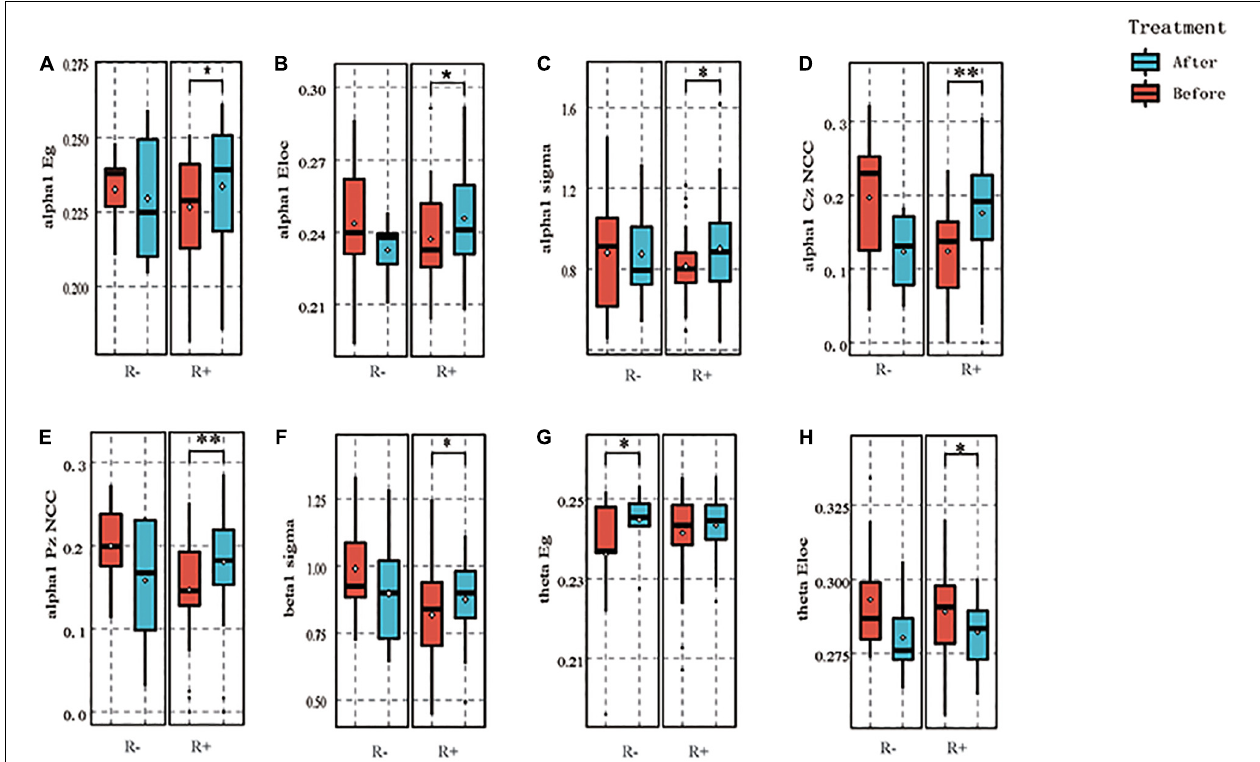
FIGURE 4 | The graph theory results for both groups. α 1 band: in the R + group, the area under the global efficiency curve increased after stimulation compared with before, p = 0.047 (A) , the area under the local efficiency curve increased compared with before, p = 0.033 (B) , and its small-world index sigma increased after stimulation, p = 0.026 (C) , whereas in the R- group, the above three indexes did not change significantly, p = 0.679, 0.640, and 0.924, respectively. The cluster coefficient of Cz nodes in the R + group increased compared with pre- stimulation, p = 0.003, while that of the R- group decreased after stimulation, p = 0.031 (D) , the cluster coefficient of Pz nodes in the R + group increased compared with that before stimulation, p = 0.003, while that of the R- group did not differ significantly, p = 0.130 (E) . Beta1 band: in the R + group, the small-world attribute sigma was elevated after stimulation compared to before, p = 0.011, while there was no significant difference in the R- group, p = 0.392 (F) . theta band: no significant difference was seen in the R + group between before and after stimulation for global efficiency, p = 0.285, while the R- group was elevated after stimulation compared to before, p = 0.039 (G) ; local efficiency in the R + group decreased after stimulation compared to before stimulation for local efficiency, p = 0.034; while no significant difference was seen in the R- group before and after stimulation, p = 0.181 (H) . * p < 0.05, ** p <